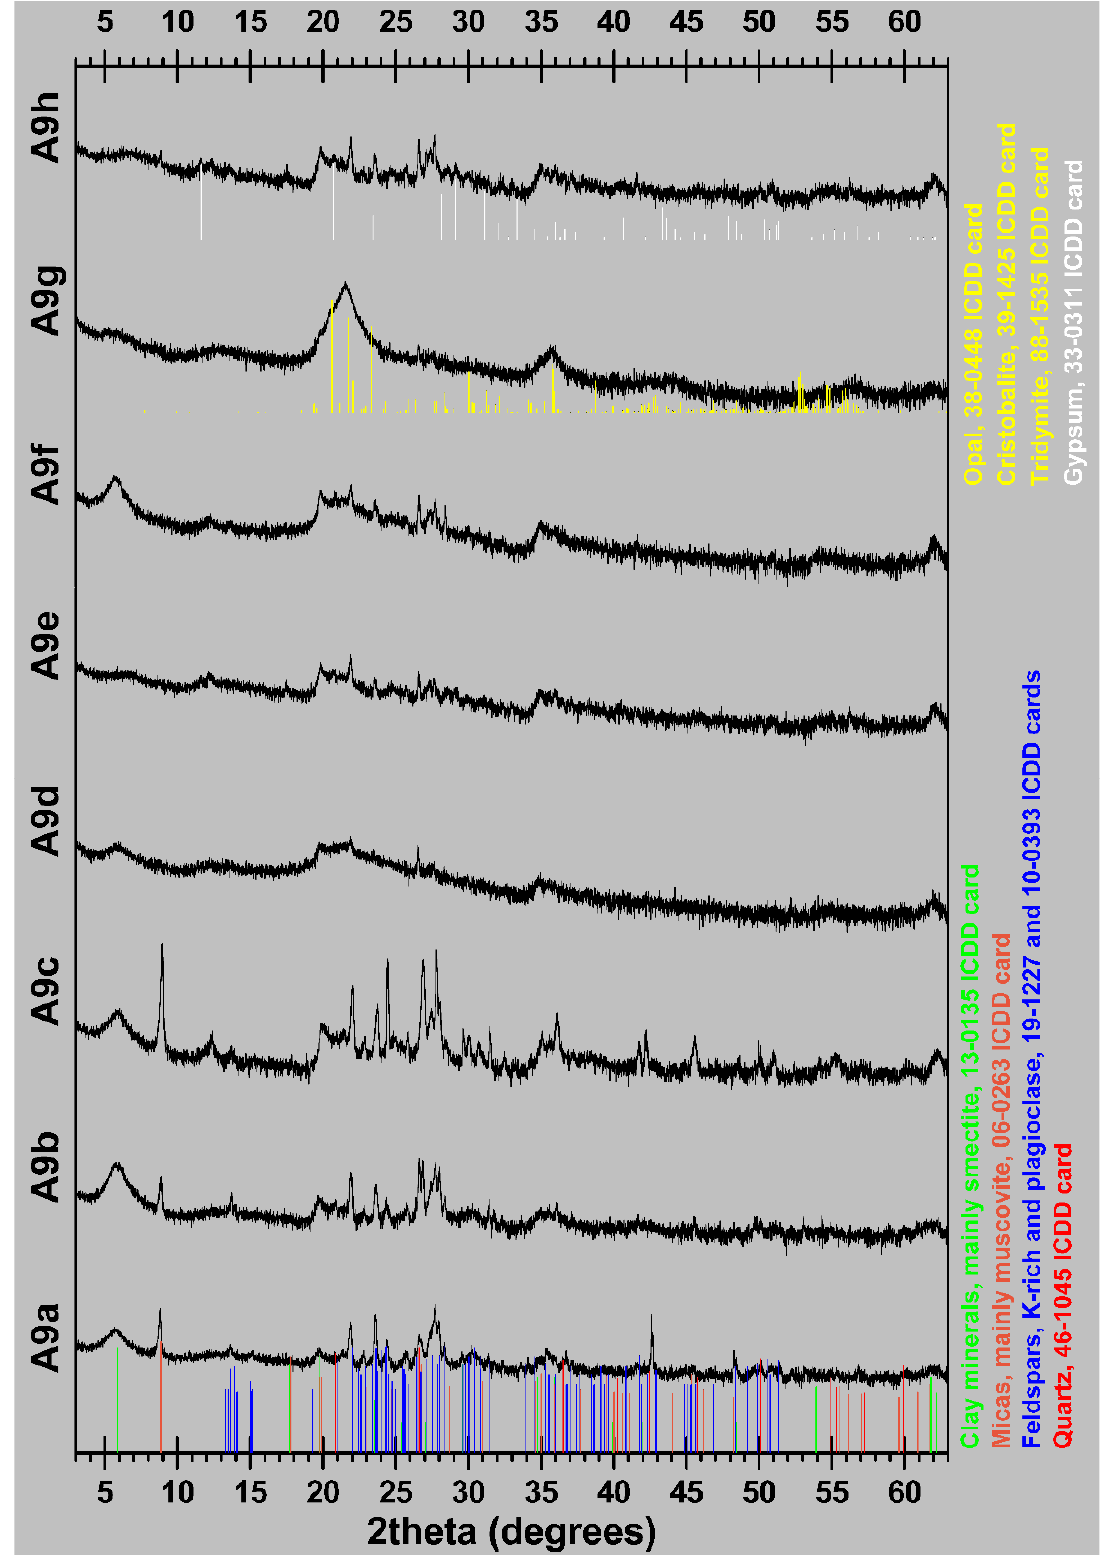
Figure 2. XRD patterns of the studied samples.